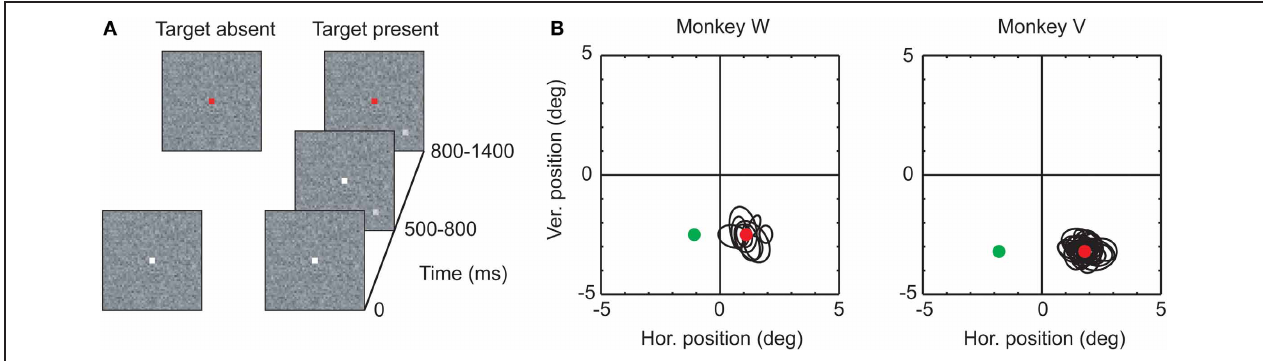
FIGURE 1 | (A) Stimulus sequences in the two trial types (see text for a description of the task). (B) Receptive fields and target locations for the two monkeys. Black ellipses: Receptive field locations recorded at the V1 site